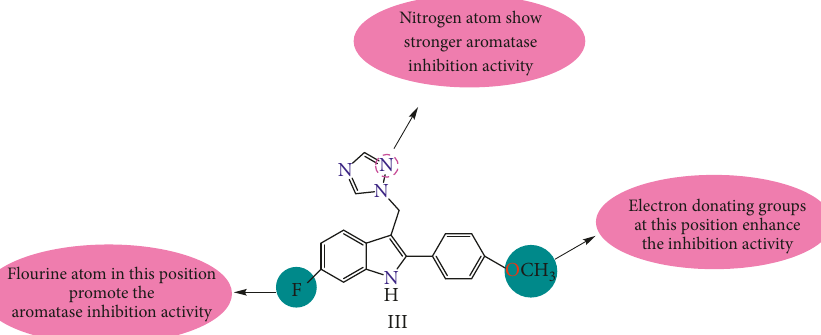
Figure 8: Structure-activity relationship of the triazole bearing indole derivative (III).